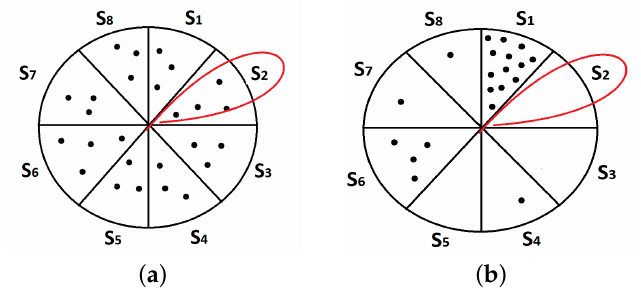
Figure 7. Uniform node distribution vs. non-uniform using round-robin approach. ( a ) Uniform node distribution. ( b ) Non-uniform node